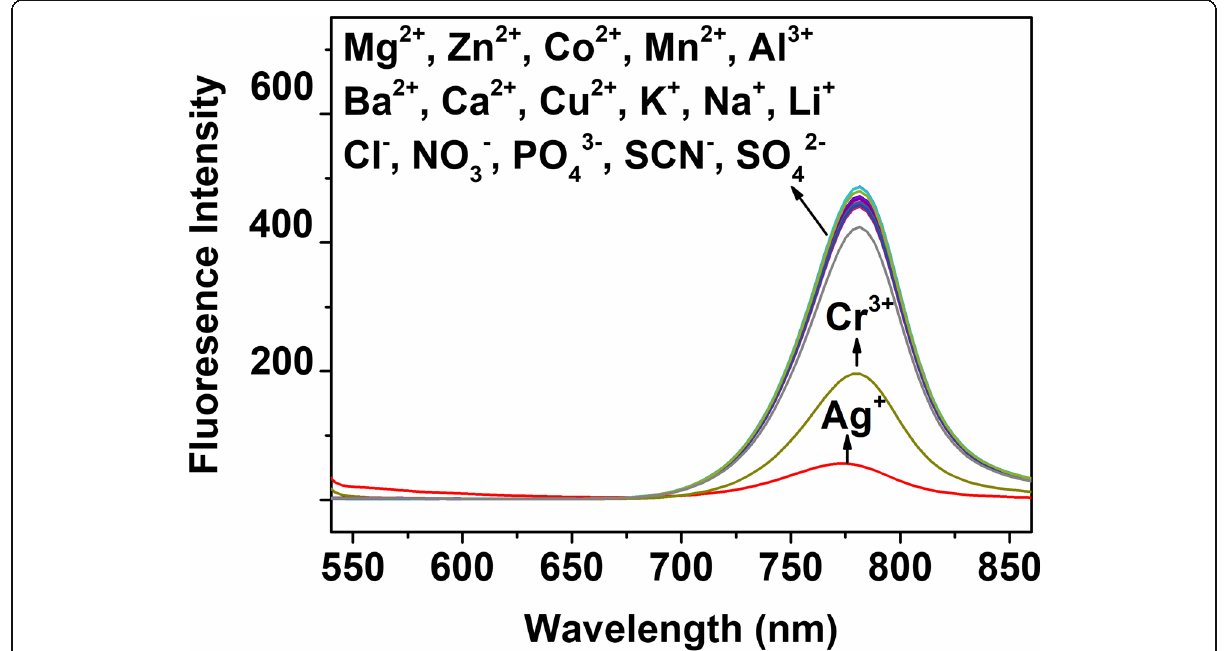
Fig. 6 Fluorescence intensity of probe 1 in HEPES buffer solution with various metal ions and